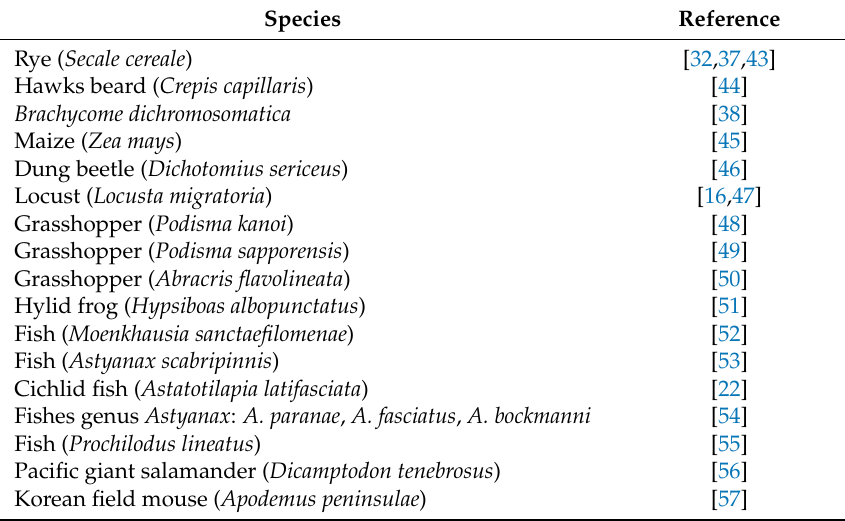
Table 1. Isolation of B chromosomes by microdissection.